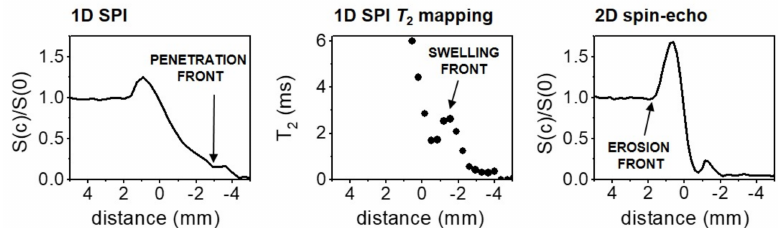
Figure 4. Determination of the moving fronts: the penetration front was determined from 1D SPI normalized signal intensity; the swelling front was determined from the T 2 profile; and the erosion front was obtained from the one-dimensional signal intensity profile along the horizontal direction of the 2D MR image. Zero on the x axis represents the surface of the tablet at the beginning of the